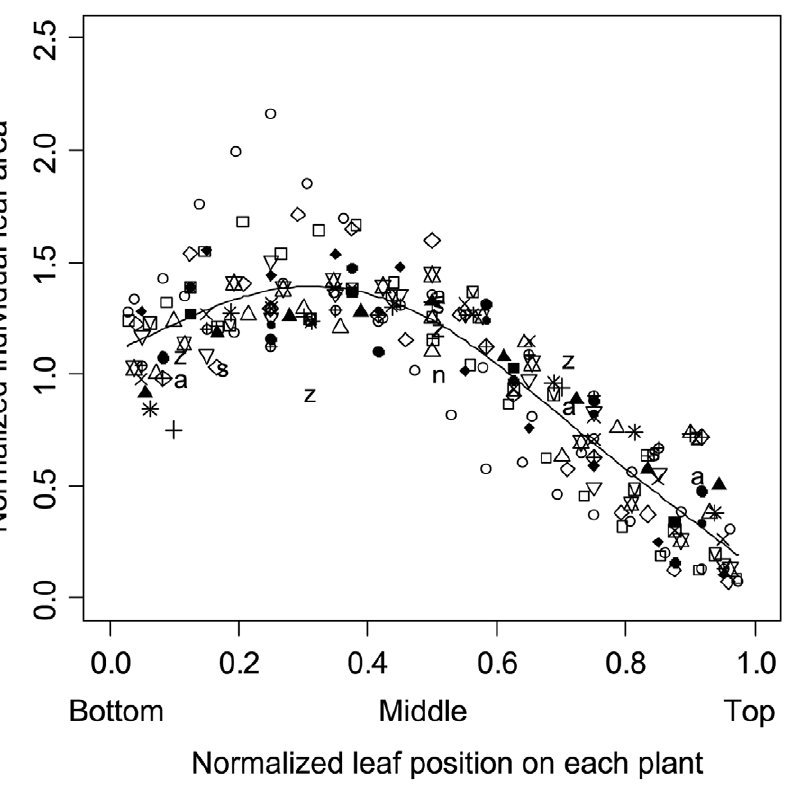
Figure 3. The normalized intra-plant leaf size distribution. Each symbol represents the relationship between the normalized position (relative number of leaves counted from the bottom to top of the stem, where 0= bottom, 0.5= middle and 1.0= top of the stem) and the normalized leaf area (area of an individual leaf divided by the averaged leaf area for the plant) of each leaf ( n =208). Each series shows an entire set of leaves for each plant ( n =29). The bold curve represents the fitted curve estimated by using the gam function in the mgcv package of R [29] ( r 2 =0.792).